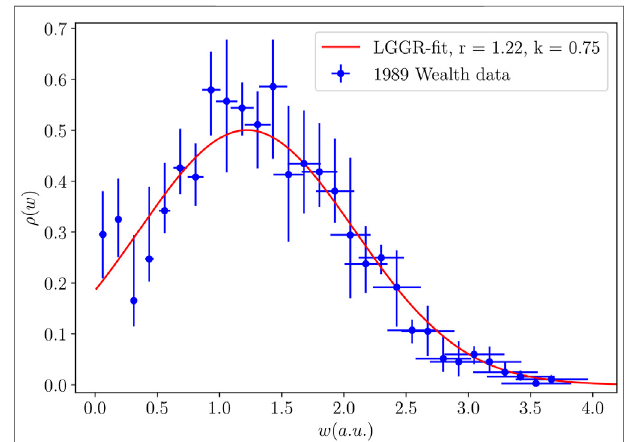
FIGURE 3 | Probability density for wealth distribution in 1989. Error bars are obtained by combining the results of the different weight parameter sets shownin Table3 .Wealthvaluesaregiveninarbitraryunits(a.u.)asitisargued in Section 2.2 . The theoretical distribution ( Eq. 9 ) fi tted to the averaged experimental distribution ( k = 0.75 and r = 1.22) is shown by the continuous line.